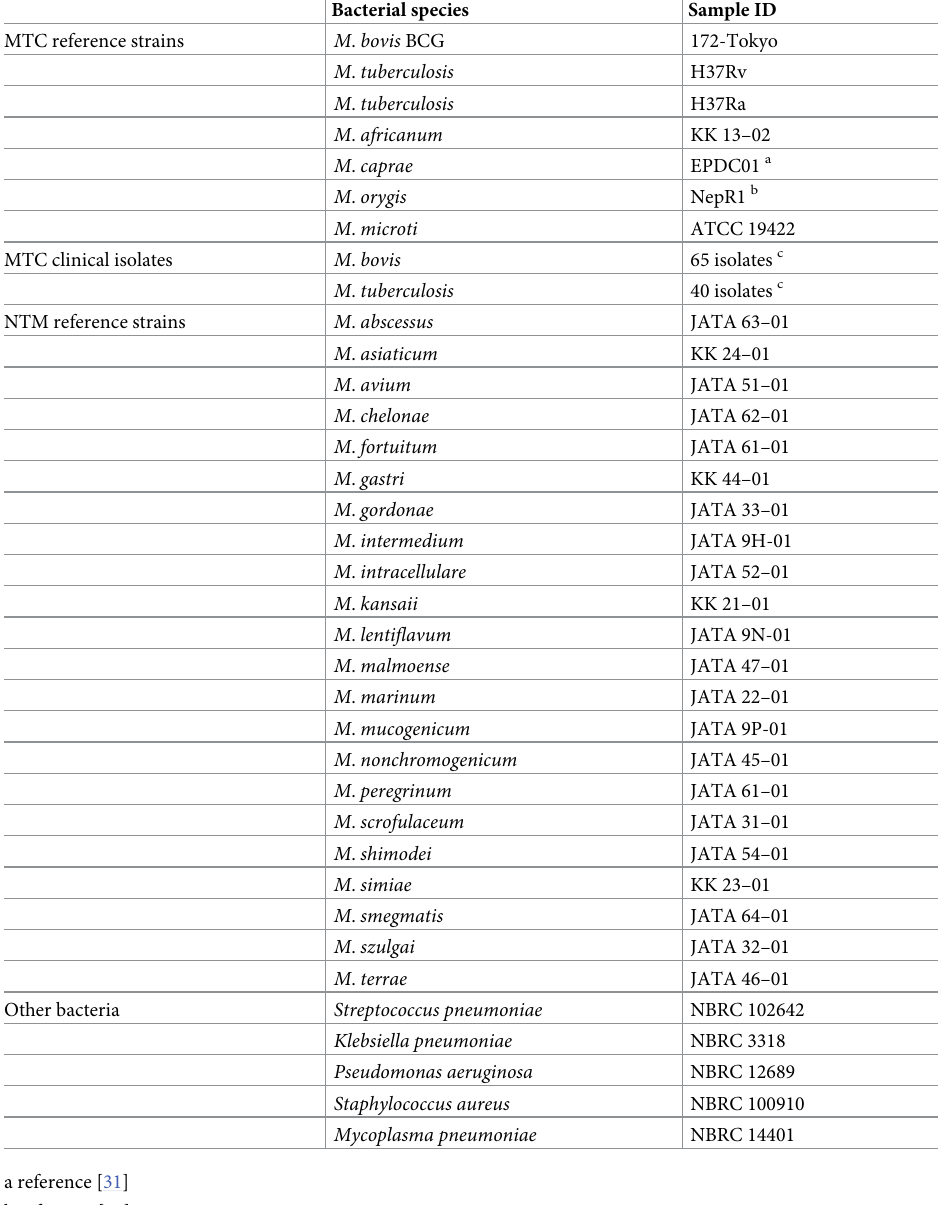
Table 1. Bacteria used in this study to determine